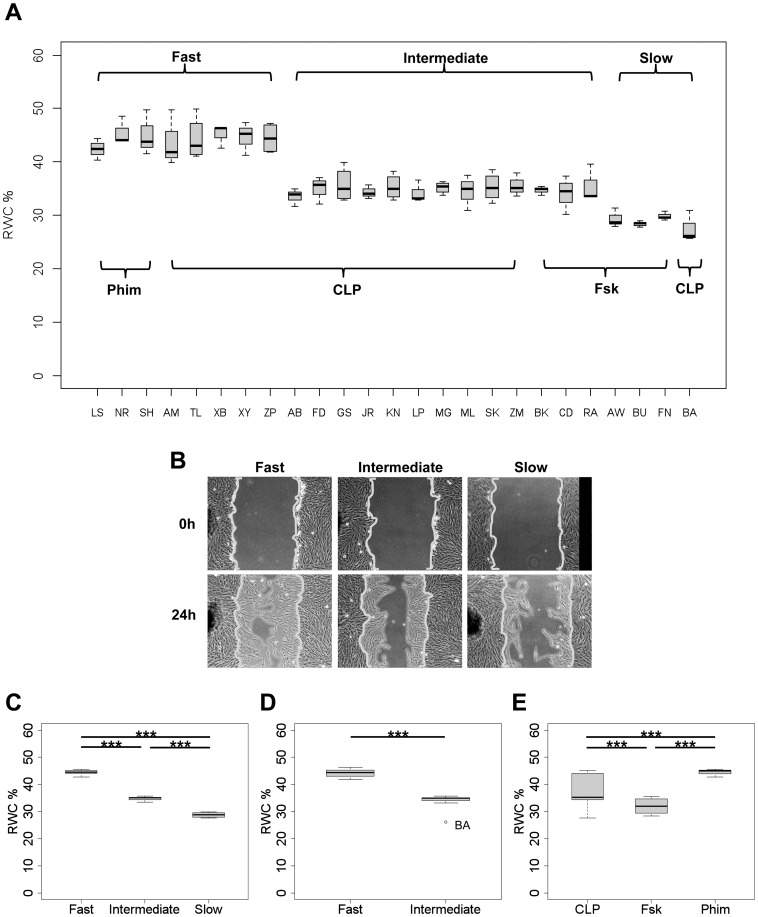
Fibroblasts from CLP patients fall into statistically distinct groups based on wound closure in vitro.Fibroblast strains were obtained from 16 CLP patients, 6 healthy individuals (foreskin; Fsk) and 3 patients with phimosis (Phim), and scratch wound assays were performed in vitro (see Materials and Methods). Box plots show the percentage of relative wound closure after 24 hours (% RWC) and the distribution of the collected data of at least three independent experiments (***p<0.001). (A) Box plots of the individual cell strains are marked at the bottom of the graph by the initials of the patients; they cluster into three distinct migratory groups namely “fast”, “intermediate” and “slow”. The origin of strains from the different proband groups is also indicated: Phimosis (Phim), cleft lip/and palate (CLP), normal foreskin (Fsk). See Tables S2 and S3 for descriptive data and p-values, respectively. (B) Representative images of one strain from each of the three migratory groups, taken immediately after wounding (0 h) and 24 hours later (24 h). Area of scale bar corresponds to 10% RWC or 0.32
mm2. (C) Box plots of the median RWC values obtained for all cell strains within each of the three migratory groups. (D) Two distinct migratory groups within the CLP patient cohort are evident after performing a multiple comparisons test with the data collected from CLP fibroblast strains alone. The fibroblast strain derived from patient “BA” was considered an outlier and therefore not included in this statistical analysis. See Tables S2 and S4 for the descriptive data and p-values, respectively. (E) When CLP, Fsk and Phim cell strains were grouped separately, they corresponded to statistically distinct populations, although heterogeneity within the CLP group was evident from the large variance.